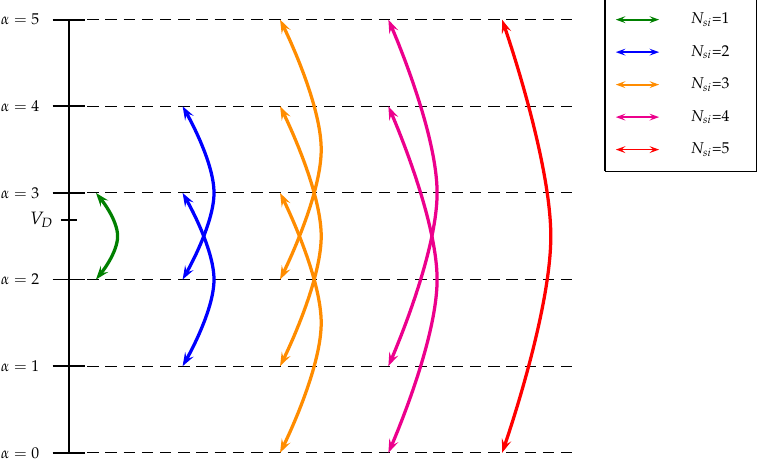
Figure 28. Possible combinations of higher and lower output voltage levels α H and α L as a function of the current level-to-level distance N si for the case m = 6 and a desired voltage V D in between “2” and “3”.